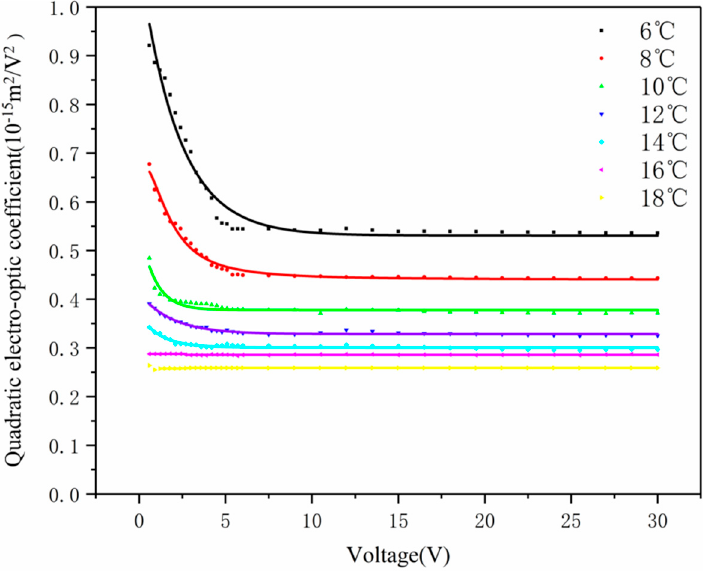
Figure 7. The quadratic electro-optical coefficients under different AC modulation voltages in the temperature range of 6–18 °C (the solid line is the fitting result).